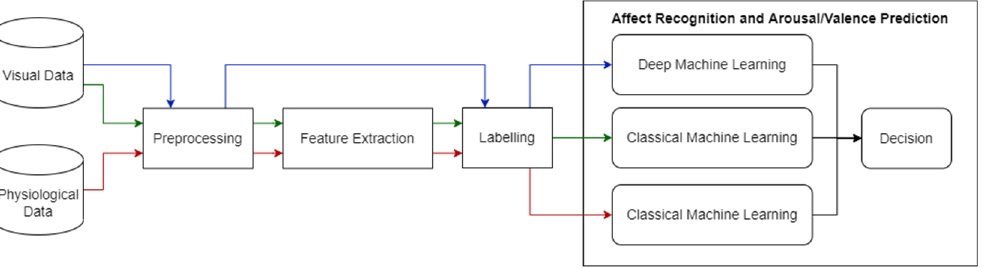
Figure 1. Overview of Proposed Solution. The red line represents the work done in this paper, while the blue and green lines represent future work.